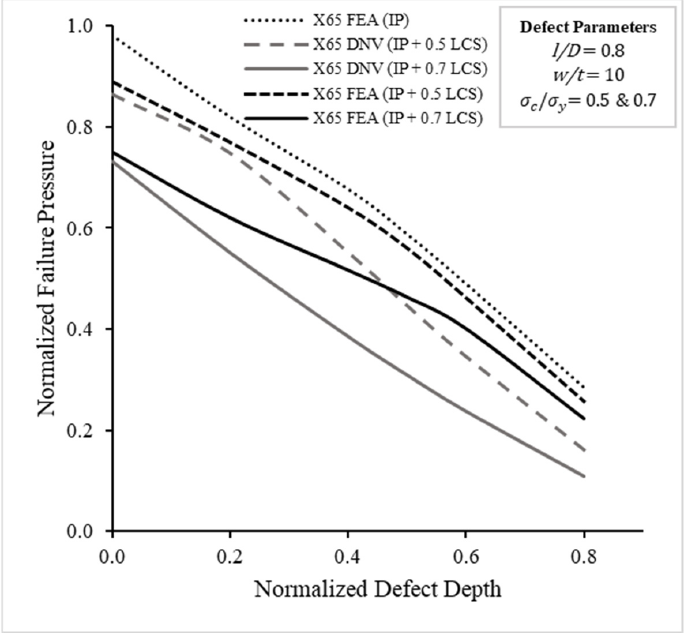
Figure 10. FEA and DNV predictions of normalized failure pressure predictions versus normalized defect depth with 0.5 and 0.7 normalized longitudinal compressive stress.